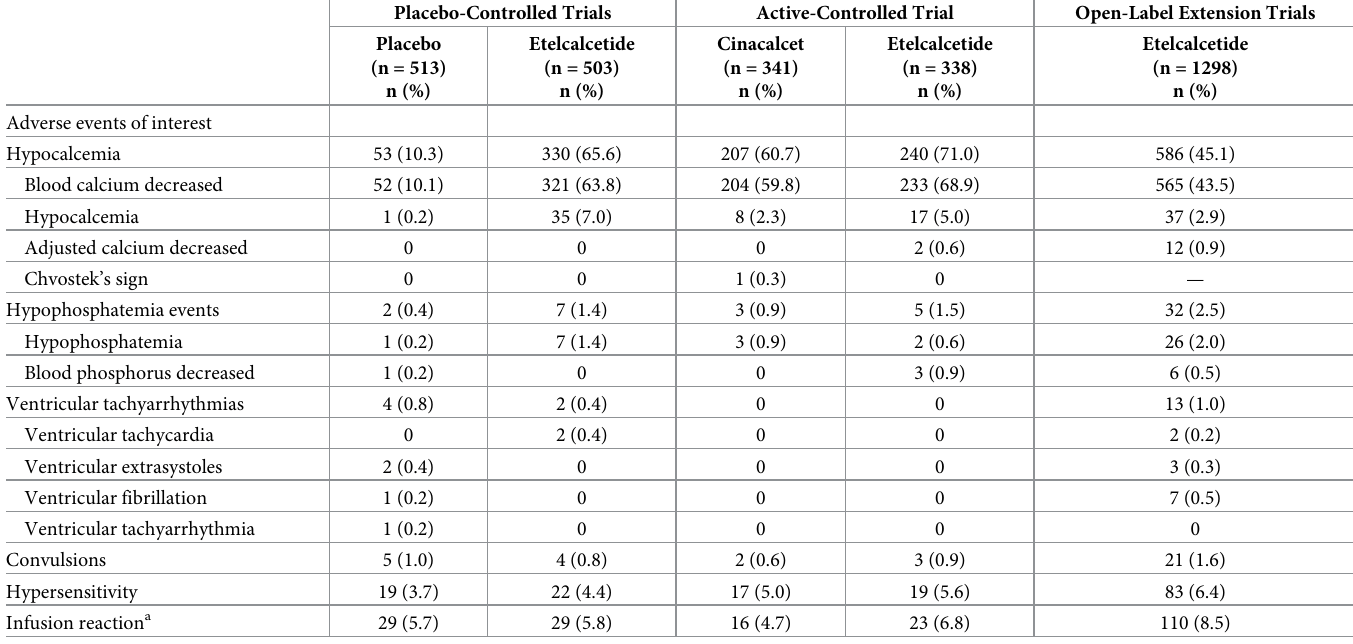
Table 4. Patient incidence of treatment-emergent adverse events of